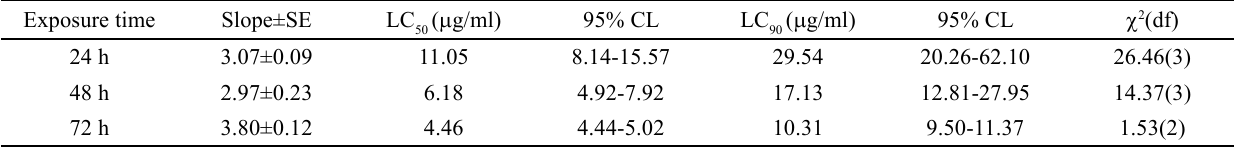
Table 1 . Toxicity of fipronil towards C. formosanus after exposure for 24, 48 and 72